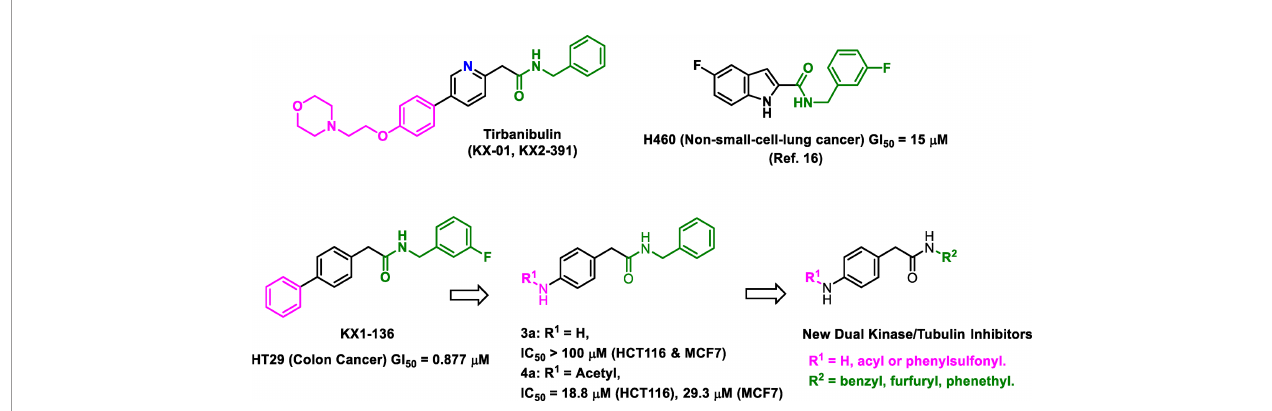
FIGURE 1 | Structures of leading non-ATP competitive Src/tubulin dual inhibitors and the Scaffold-Hopping of KX1-136 into derivatives of 4-(acylamino)- N -